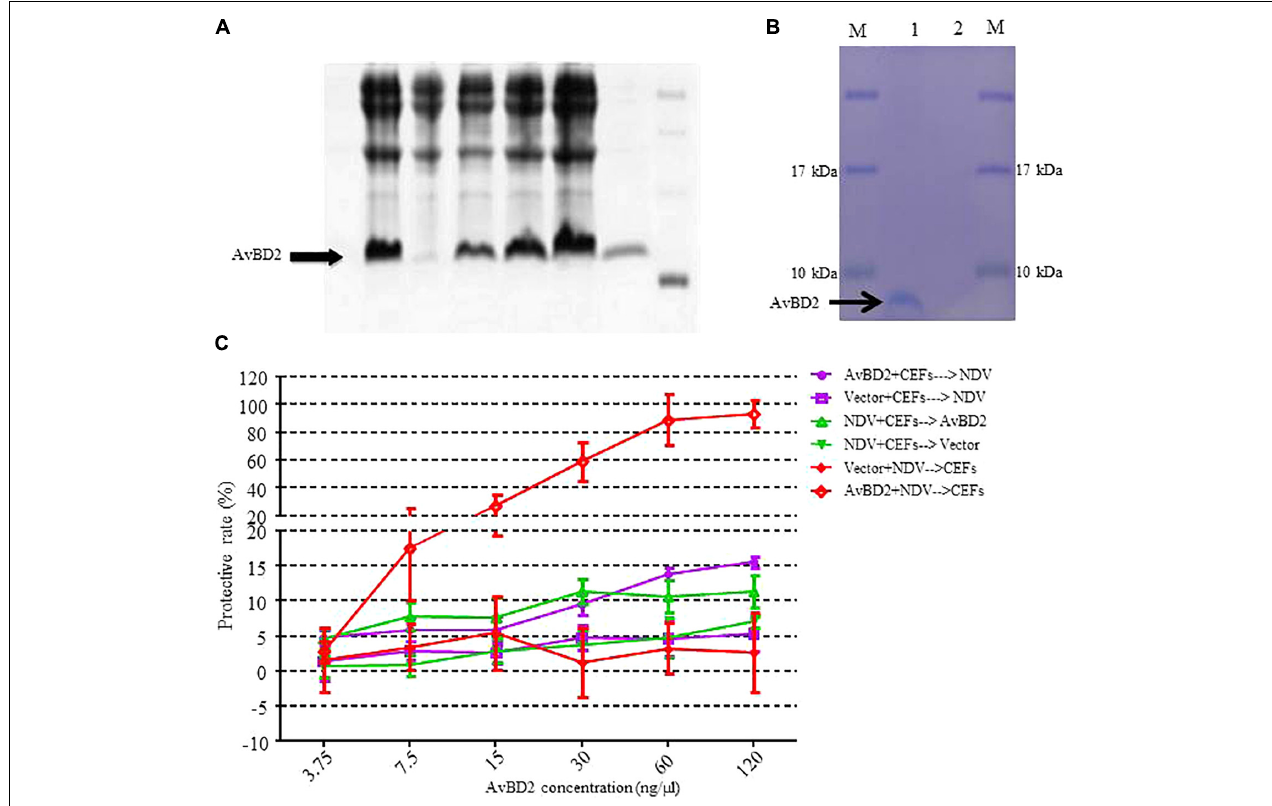
FIGURE 3 | Recombinant expression of AvBD2 protein and antiviral activity of AvBD2 against NDV. (A) 12% SDS–PAGE analysis of His-tagged recombinant AvBD2 protein expressed in E . coli BL21 (DE3) cells. Lane 1: Supernatant; lane 2: Inclusion body; lane 3: Total protein of Rosetta containing AvBD2 without IPTG induction; lanes 4–6: Total protein of Rosetta containing AvBD2 at 2, 4, 6 h after induction with IPTG, respectively; lane 7: Purified recombinant AvBD2 protein; lane M: Protein marker. (B) 12% SDS–PAGE analysis of His-tagged AvBD2 protein expressed in Expi293 cells. Lane 1: purified AvBD2 with a His-tag on the C-terminal; lane 2: purified vector with a His-tag on the C-terminal; lane M: protein molecular weight marker. (C) Protection of CEFs from NDV infection by using the CCK-8 assay. Red curve , NDV (1 MOI) and AvBD2 protein (3.75–120 ng/ µ l) were mixed for 1.5 h at 37 ◦ C. Cells were washed and then incubated with the NDV-AvBD2 protein mixture for another 1.5 h at 37 ◦ C. Green curve , NDV (1 MOI) and equal volume of PB were mixed and then incubated with CEFs for 1.5 h at 37 ◦ C. Cells were washed and incubated with AvBD2 protein and equal volume of DMEM without serum for another 1.5 h. Purple curve , AvBD2 protein (3.75–120 ng/ µ l) and equal volume of DMEM without serum were mixed to incubate with CEFs for 1.5 h at 37 ◦ C. Cells were washed and then the mixtures of NDV (1 MOI) and equal volume of PB were added and incubated with CEFs for another 1.5 h at 37 ◦ C. Then, the cells were washed, and 2% DMEM were added and incubated for 48 h at 37 ◦ C. Then CCK-8 solution (5 mg/ml, 10 µ l/well) was added to the plate. The absorbance at 450 nm was measured using a microplate reader after the incubation at 37 ◦ C for 1.5 h. The vector was used as control for each group. Cells without virus-protein mixture were also used as a negative control. Cells only infected with the virus served as a positive control. The experiment was performed in